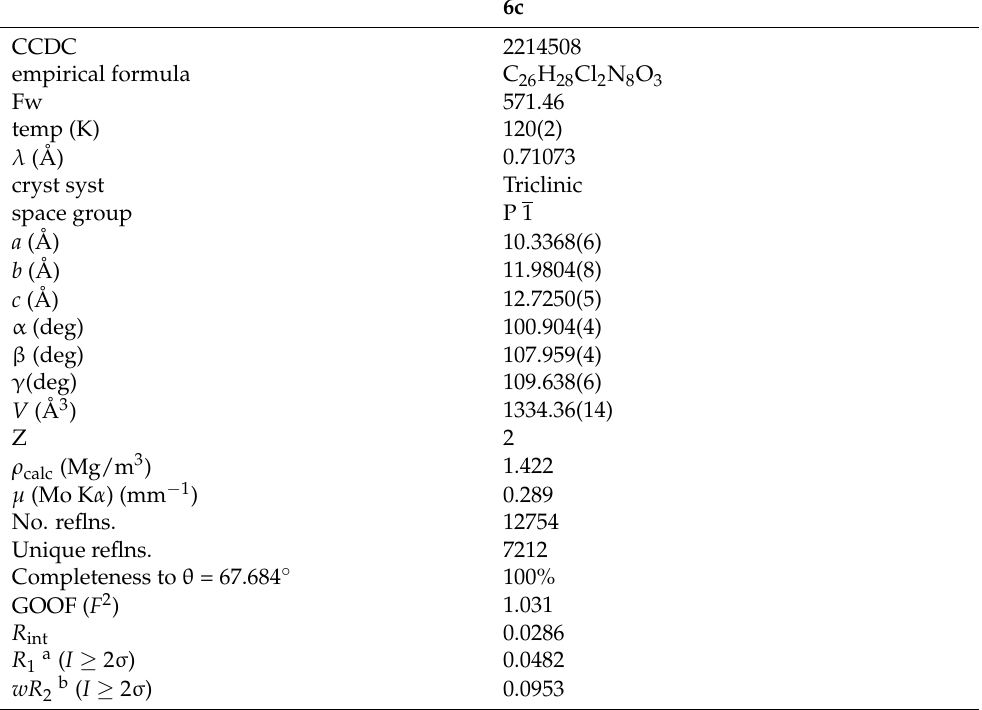
Table 1. Crystal data for 6c